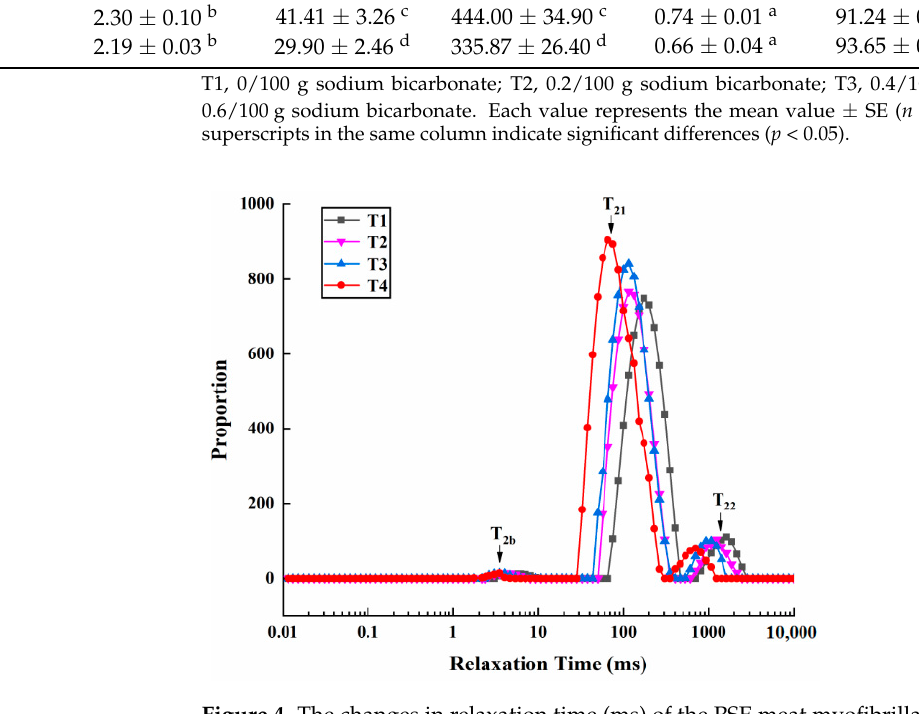
Figure 4. The changes in relaxation time (ms) of the PSE meat myofibrillar protein gels with varying amounts of added sodium bicarbonate. T1, 0/100 g sodium bicarbonate; T2, 0.2/100 g sodium bicarbonate; T3, 0.4/100 g sodium bicarbonate; T4, 0.6/100 g sodium bicarbonate.